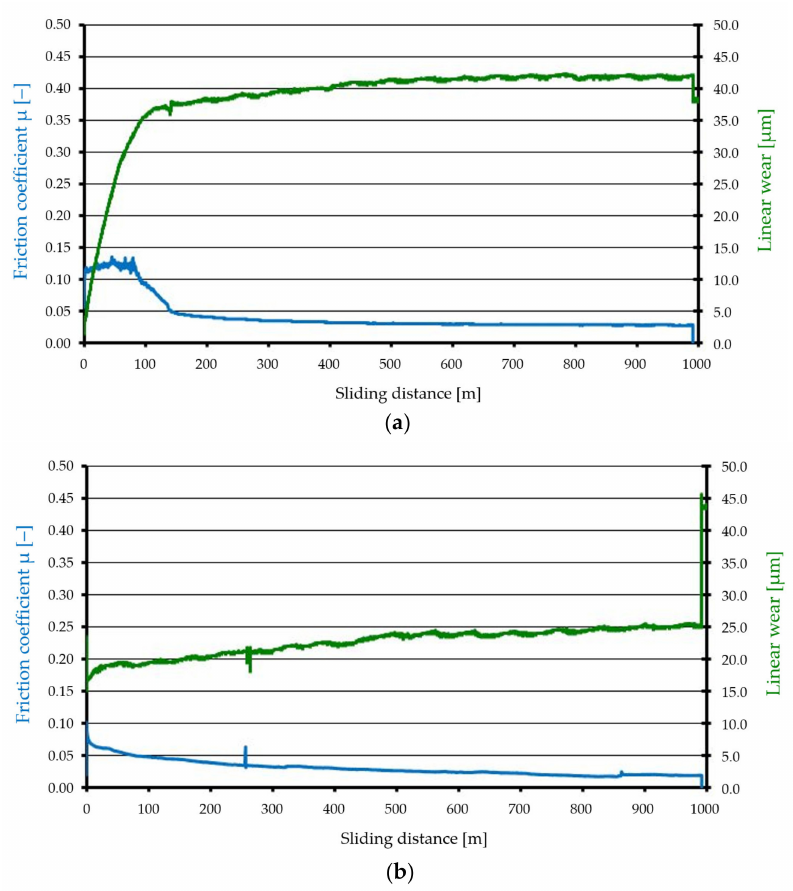
Figure 6. Tribological characteristics (studies with lubricant): ( a ) Surface A, ( b ) Surface